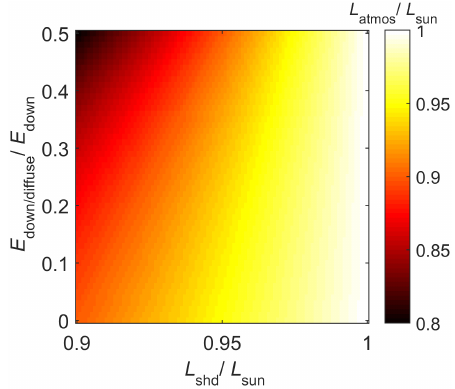
Figure 5. The ratio L atmos